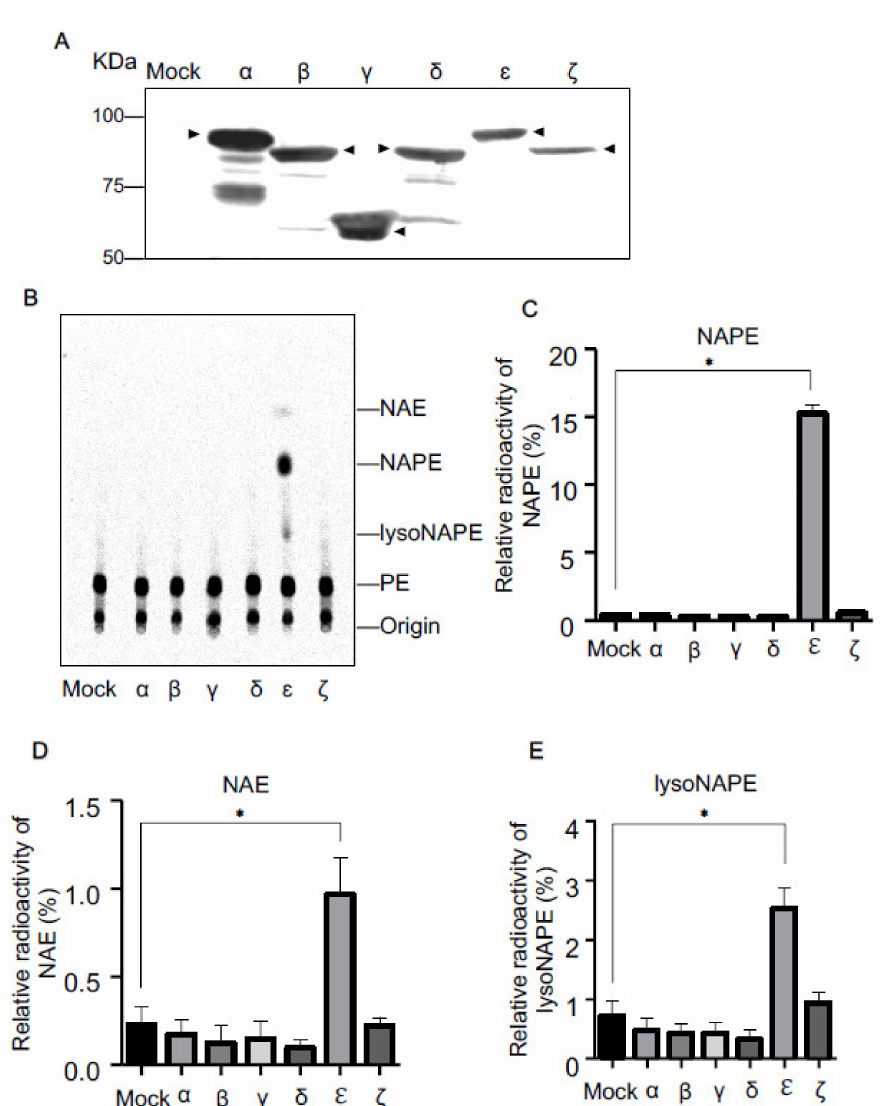
Figure 2. Metabolic labeling of cPLA 2 -expressing cells with [ 14 C]ethanolamine. HEK293 cells were transfected with the insert-free vector (Mock) or the expression vector harboring cDNA for the indicated cPLA 2 isoforms tagged with FLAG. Their expressions were confirmed by Western blotting using anti-FLAG antibody ( A ). Arrowheads indicate the positions of the deduced molecular mass of each isoform. The cells were metabolically labelled with [ 14 C]ethanolamine, followed by the treatment with ionomycin. Total lipids were then analyzed by TLC ( B ). The positions of the origin and authentic compounds are shown. The relative radioactivities of NAPE ( C ), NAE ( D ), and lysoNAPE ( E ) are shown (mean values ± S.D., n = 3). * p <